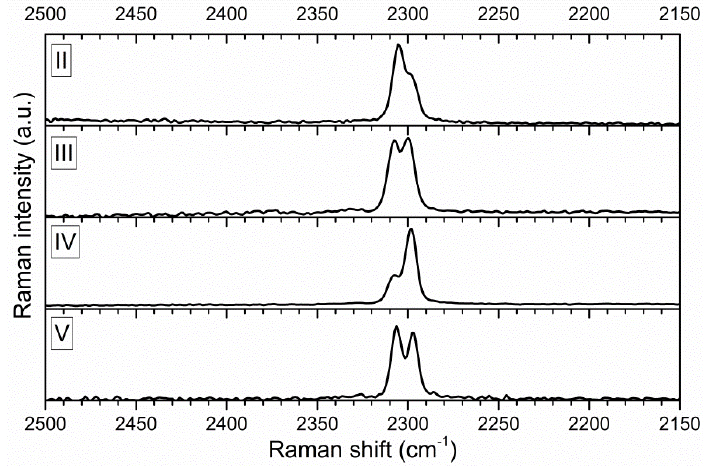
Figure 7. A detail of the Raman spectra of compounds ( II )–( V ) containing phosphite anions (region 2500–2150 cm − 1 ).